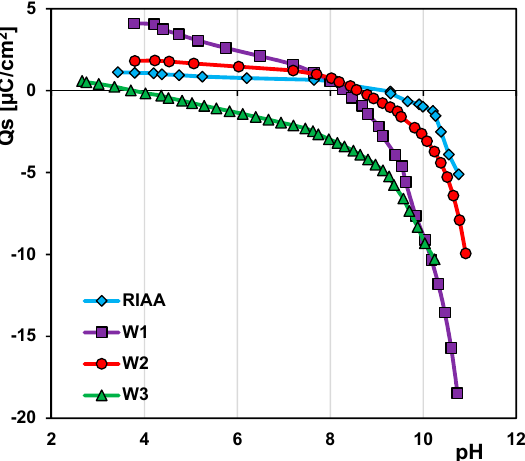
Figure 5. Dependences of surface charge density on pH for the carbonaceous materials.